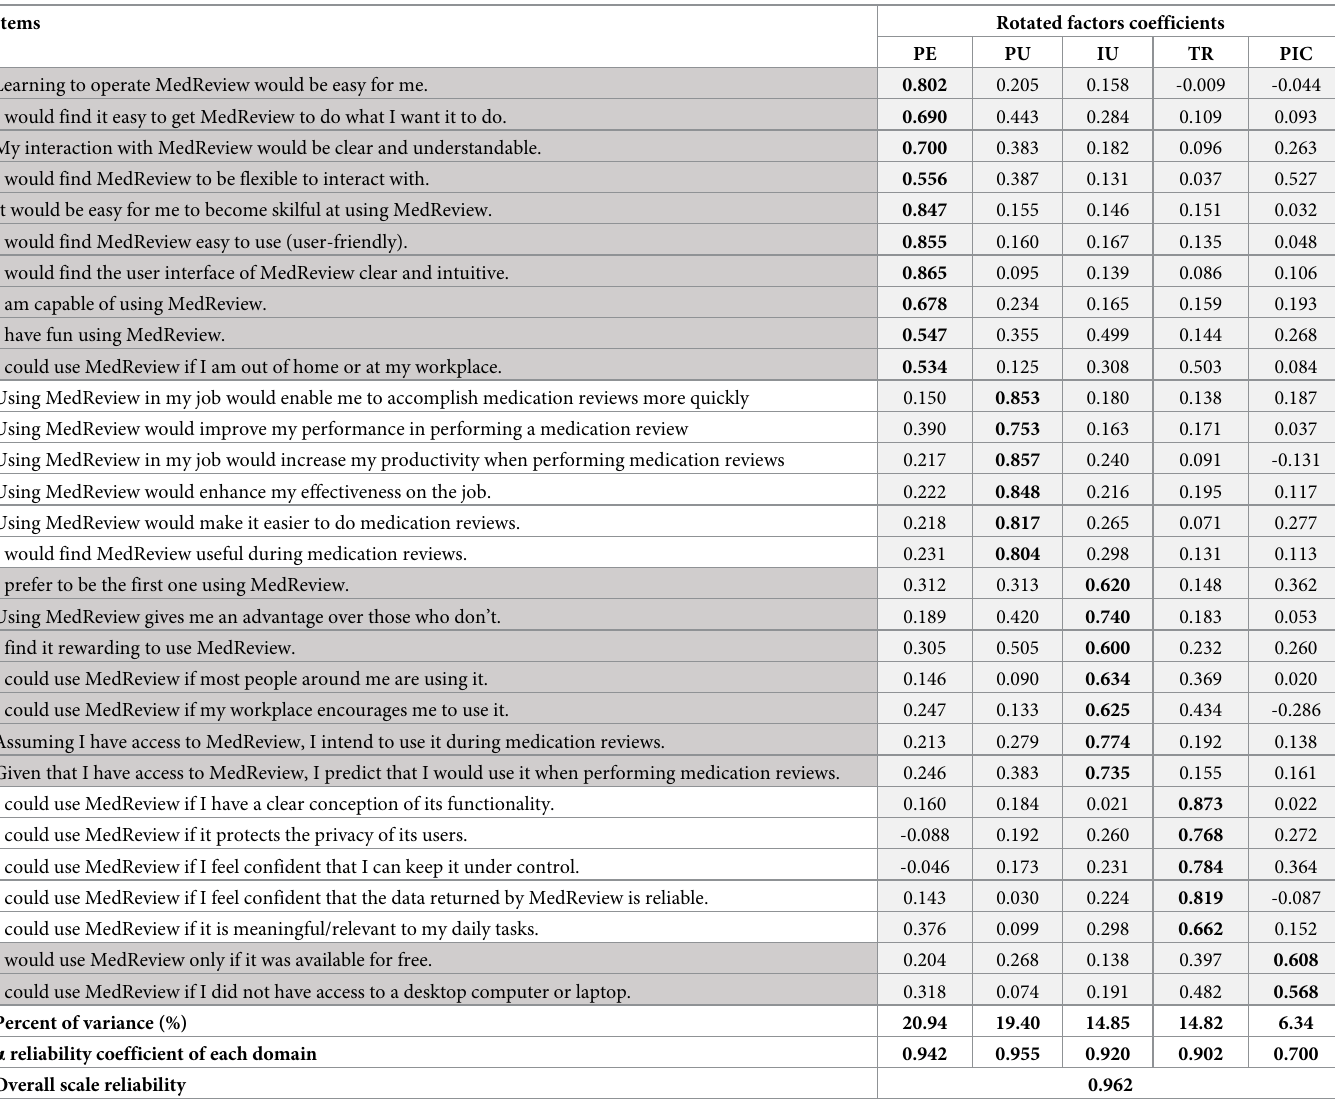
Table 1. Summary of factor analysis, item-total score correlations, and reliability of the survey (construct